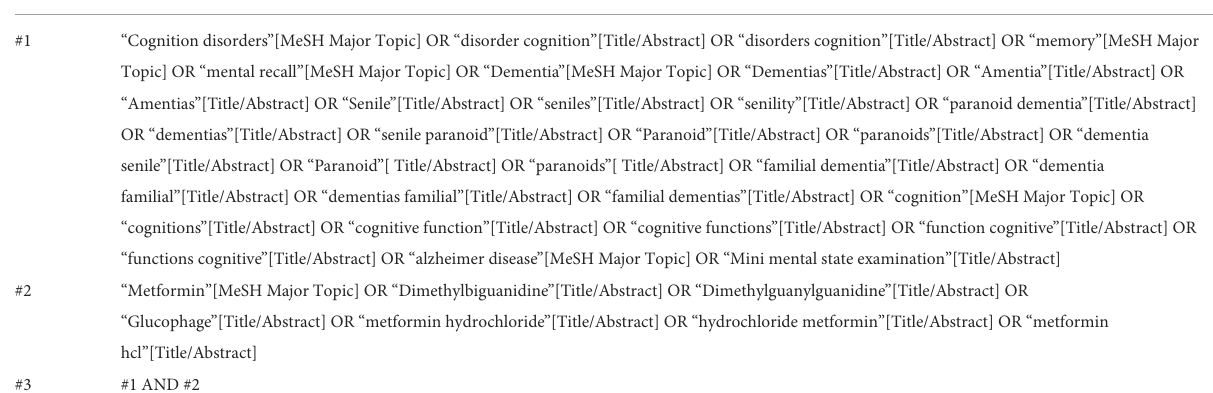
TABLE 1 Search strategy of PubMed